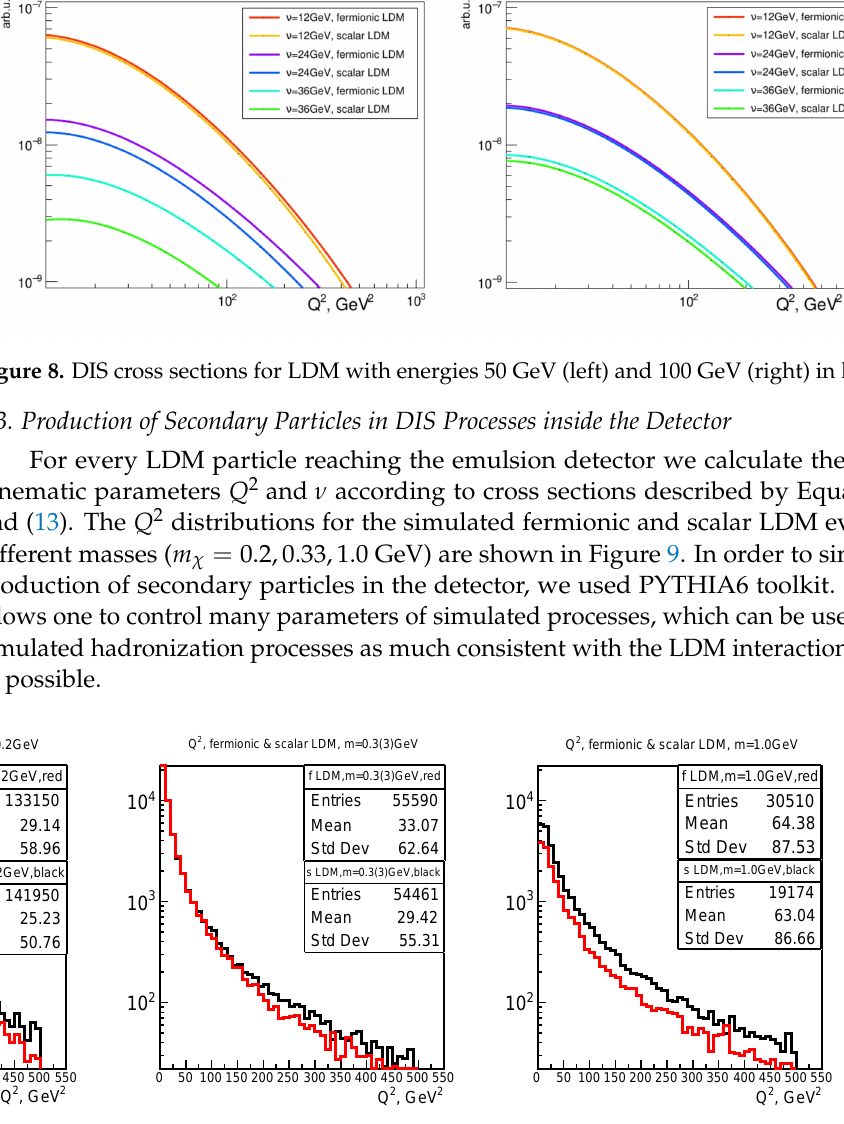
Figure 9. Q 2 distributions for fermionic and scalar LDM particles with different